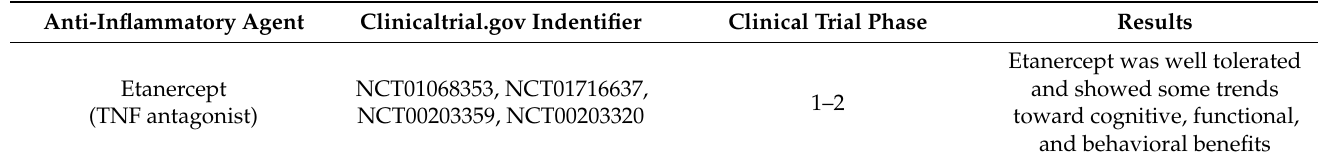
Table 2. Updates on clinical trials with the use of agents which potentially reduce neuroinflammation. Anti-Inflammatory Agent Clinicaltrial.gov